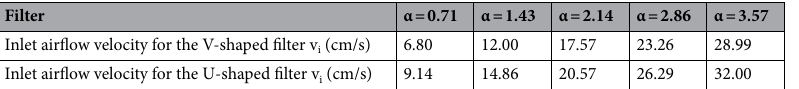
Table 2. Inlet air velocities when the filtration velocity is 4